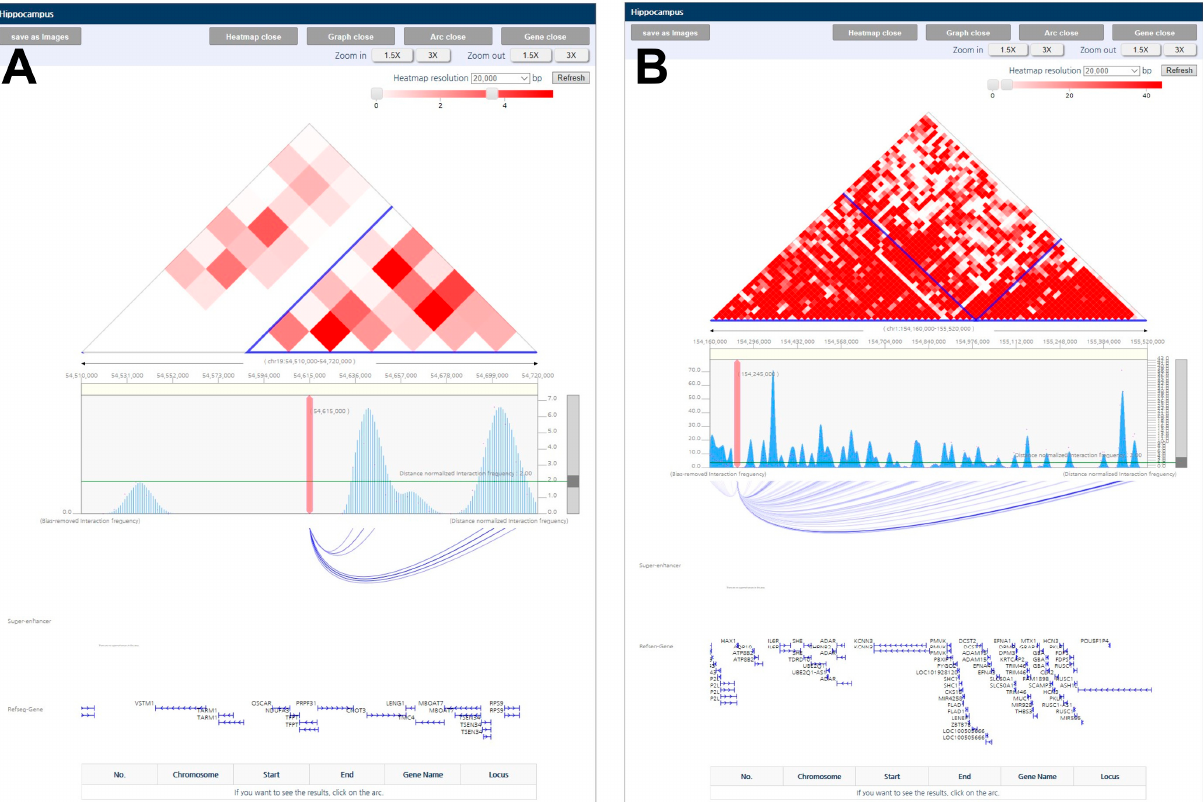
Figure 3. De novo variant genes associated with neurological functional genes in the TAD. ( A ) TFPT is associated with CNOT3 in the same TAD. ( B ) HAX1 is associated with ASH1L in the same TAD.